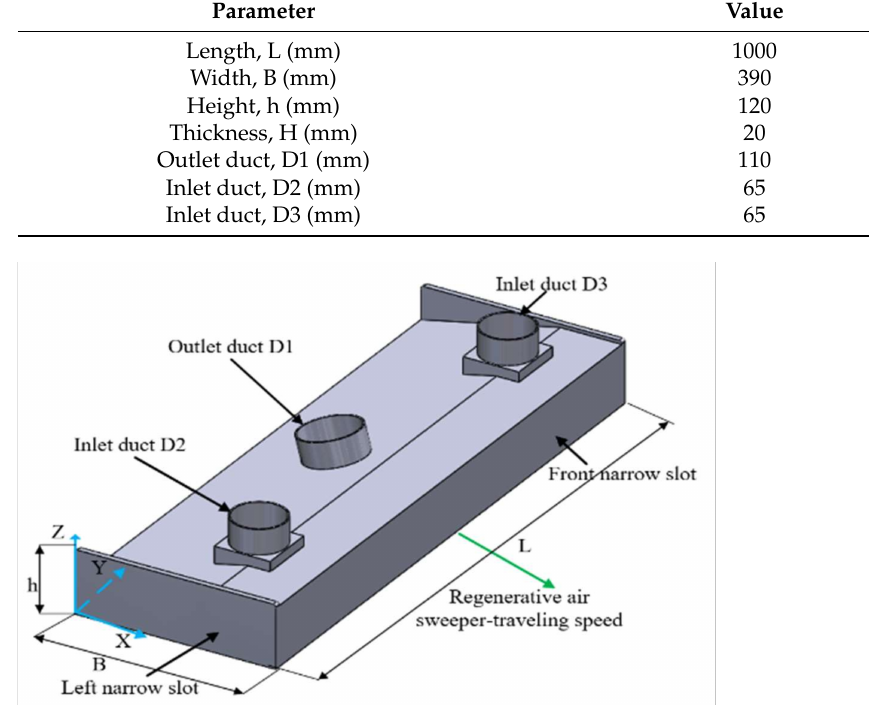
Table 1. The main dimensions of the regenerative sweeper pick-up head.